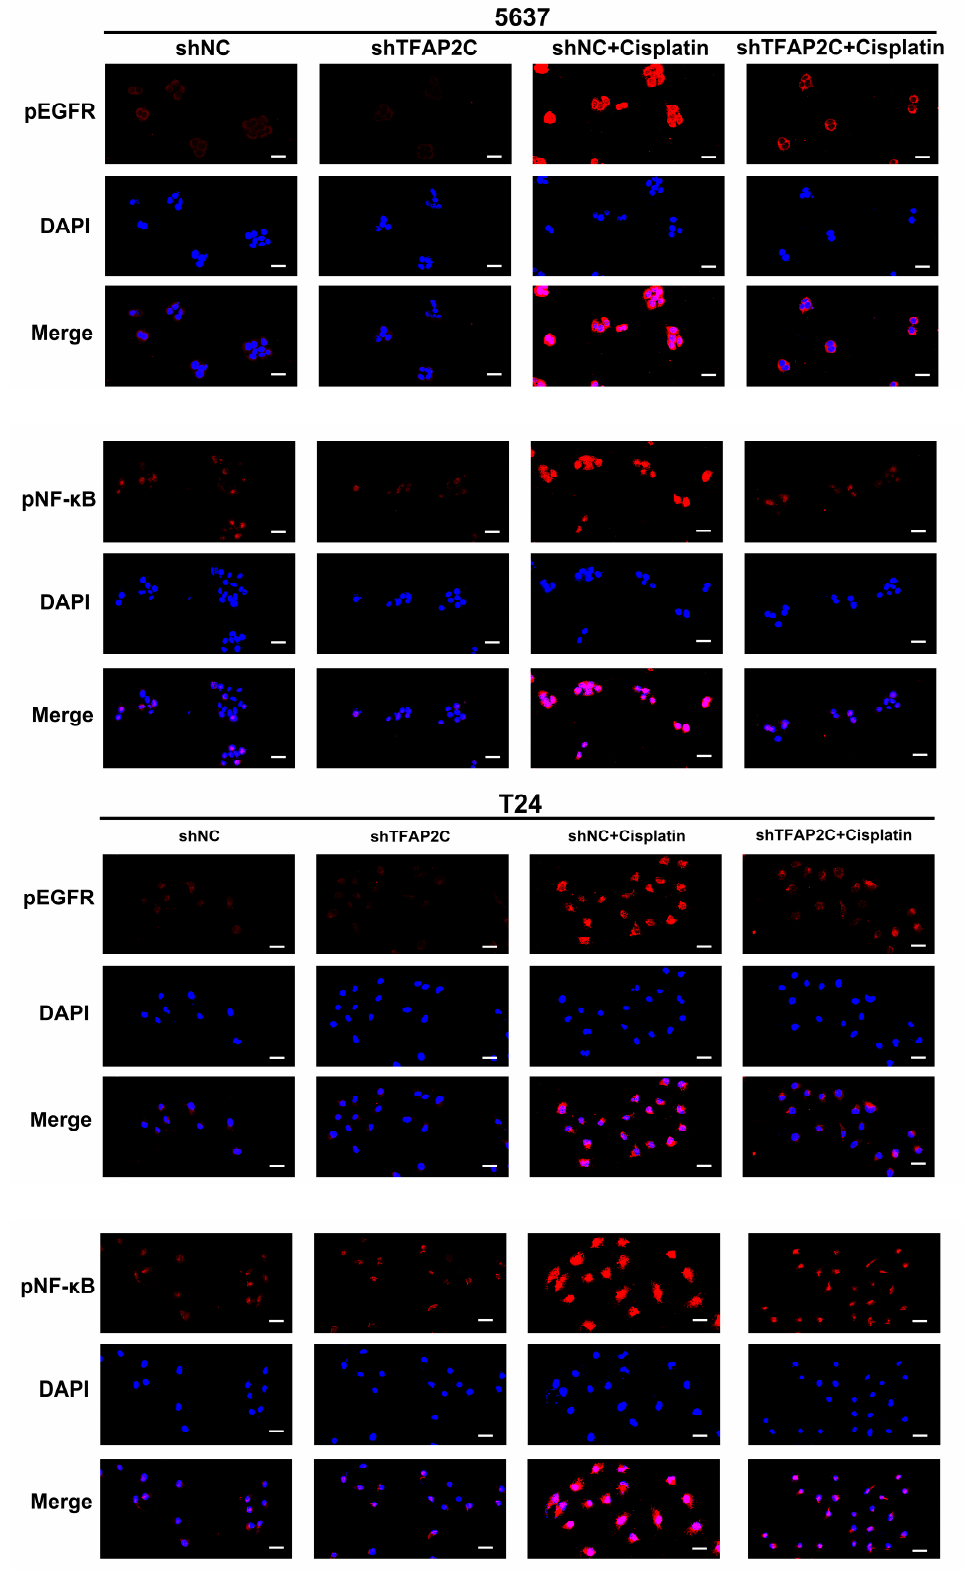
Figure 7. Representative images of pEGFR and pNF- κ B immunostaining. Scale bars, 20 µm.